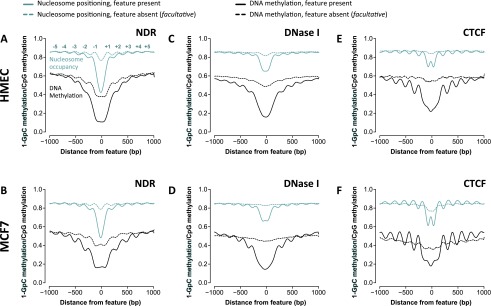
NOMe-seq reveals that nucleosomes are organized throughout the genome, at nucleosome-depleted regions (NDRs) and facultativeNDRs (fNDRs). (A–F) Each genomic feature (NDR, DNase hypersensitivity, or CTCF binding site) was called as “present” (solid lines) or “absent” (broken lines) in HMEC (upper panels) or MCF7 (lower panels). Nucleosome occupancy and endogenous methylation (CpG) were mapped ±1000 bp from the center (“0”) of each NDR, DNase I hypersensitive site, or CTCF site. (A,B) NOMe-seq demonstrates that nucleosomes are present on either side of a NDR (solid teal lines) and across the genome, even at less pronounced or absent NDRs (broken teal line). DNA methylation is phased alongside nucleosomes (black lines) regardless of nucleosome occupancy; however, DNA methylation is typically low (∼20%) within NDRs (solid black line). (C,D). DNase I hypersensitive sites are characterized by organized nucleosomes (solid teal lines), whereas DNA methylation (solid black lines) is low at the center, then phased, and then increases with distance from the center of the DNase I site (solid black line) similar to patterns observed around NDRs. (E,F). CTCF is associated with nucleosome patterns (solid teal lines) and phased peaks of DNA methylation (solid black lines) between the nucleosomes. In the absence of CTCF, nucleosomes are not phased (broken teal lines), and a continuous high level of DNA methylation is observed (∼60%).